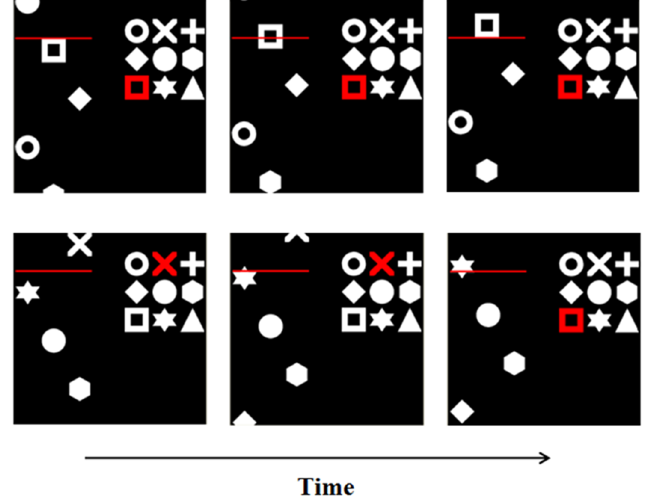
Figure 1. Swansea Test of Attentional Control. Participants view a 3 × 3 matrix of symbols (screen right) and a continuous stream of symbols (screen left). Top: The symbols on the left scroll up the screen. Where an oncoming symbol matches the target (highlighted in red, on the right), participants respond when that shape crosses the red line (as opposed to before or after). Bottom: The target changes every 19 s, such that participants must remain vigilant and consistently attend to both elements of the task to ensure successful performance.